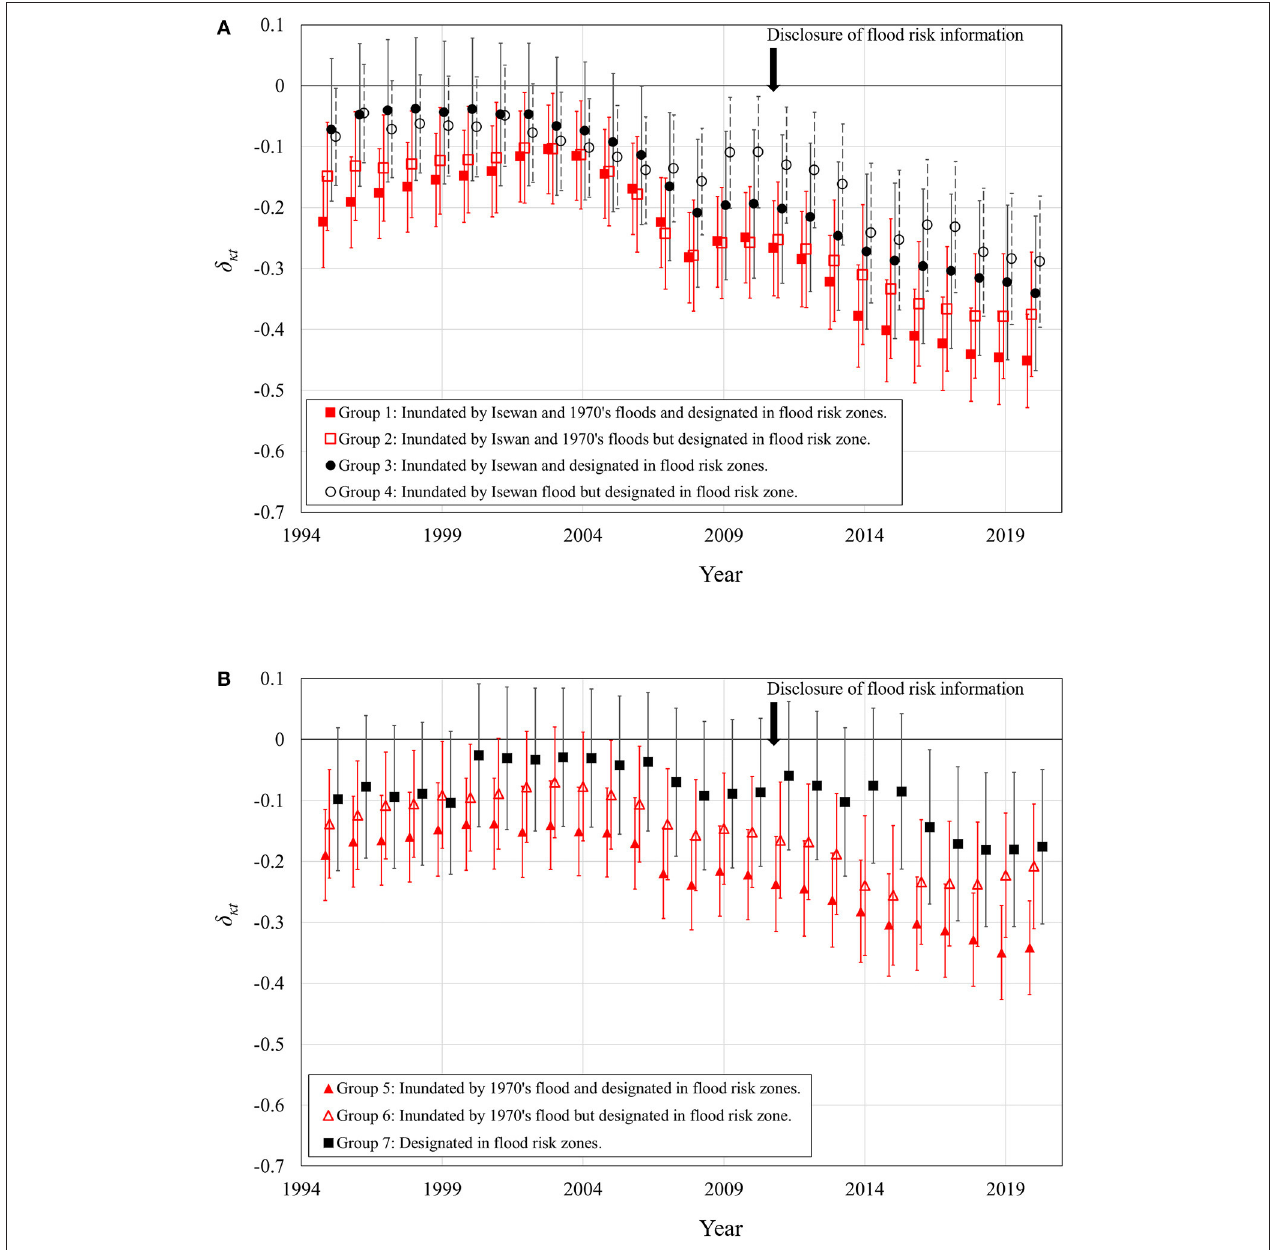
FIGURE 5 | Estimated parameters of the devaluation of properties in seven groups compared with properties that were not inundated in the Isewan and 1970’s floods and were not designated in flood risk zones, after excluding the properties in areas inundated by heavy rains in 2008, 2009, 2011, and 2013. (A) Groups 1–4. (B) Groups